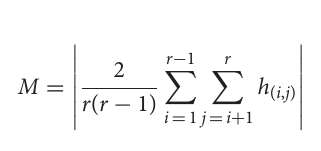
Frontiers in Physiology |